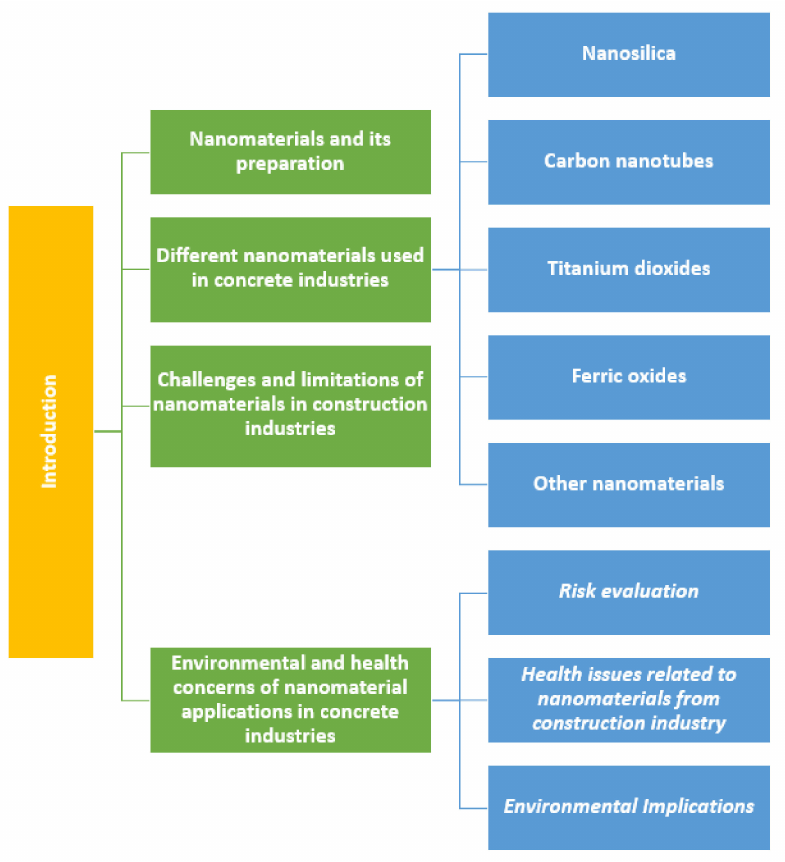
Figure 5. A schematic illustration of the study’s